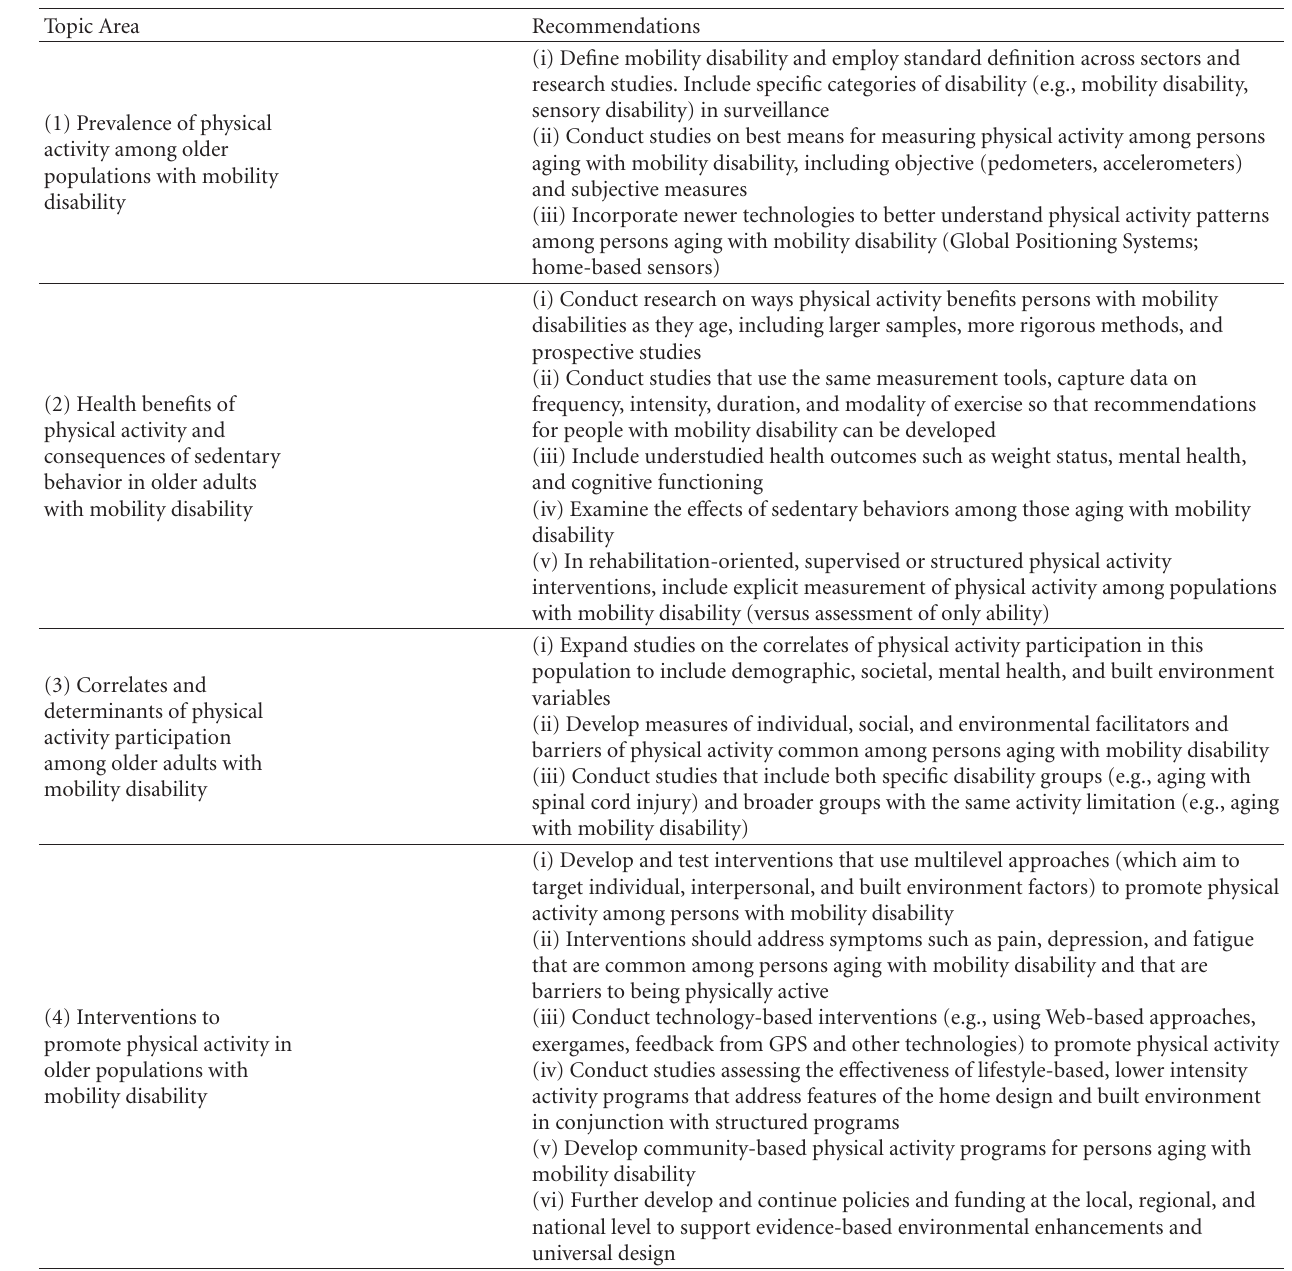
Table 1: Recommendations for research priorities related to promoting physical activity for adults aging with mobility